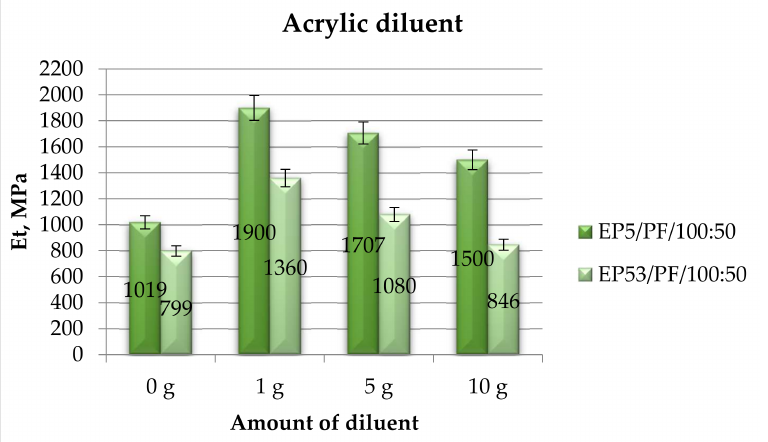
Figure 18. Tensile modulus calculated for Epidian 5 and Epidian 53 epoxy compounds as a function of the amount of acrylic diluent.